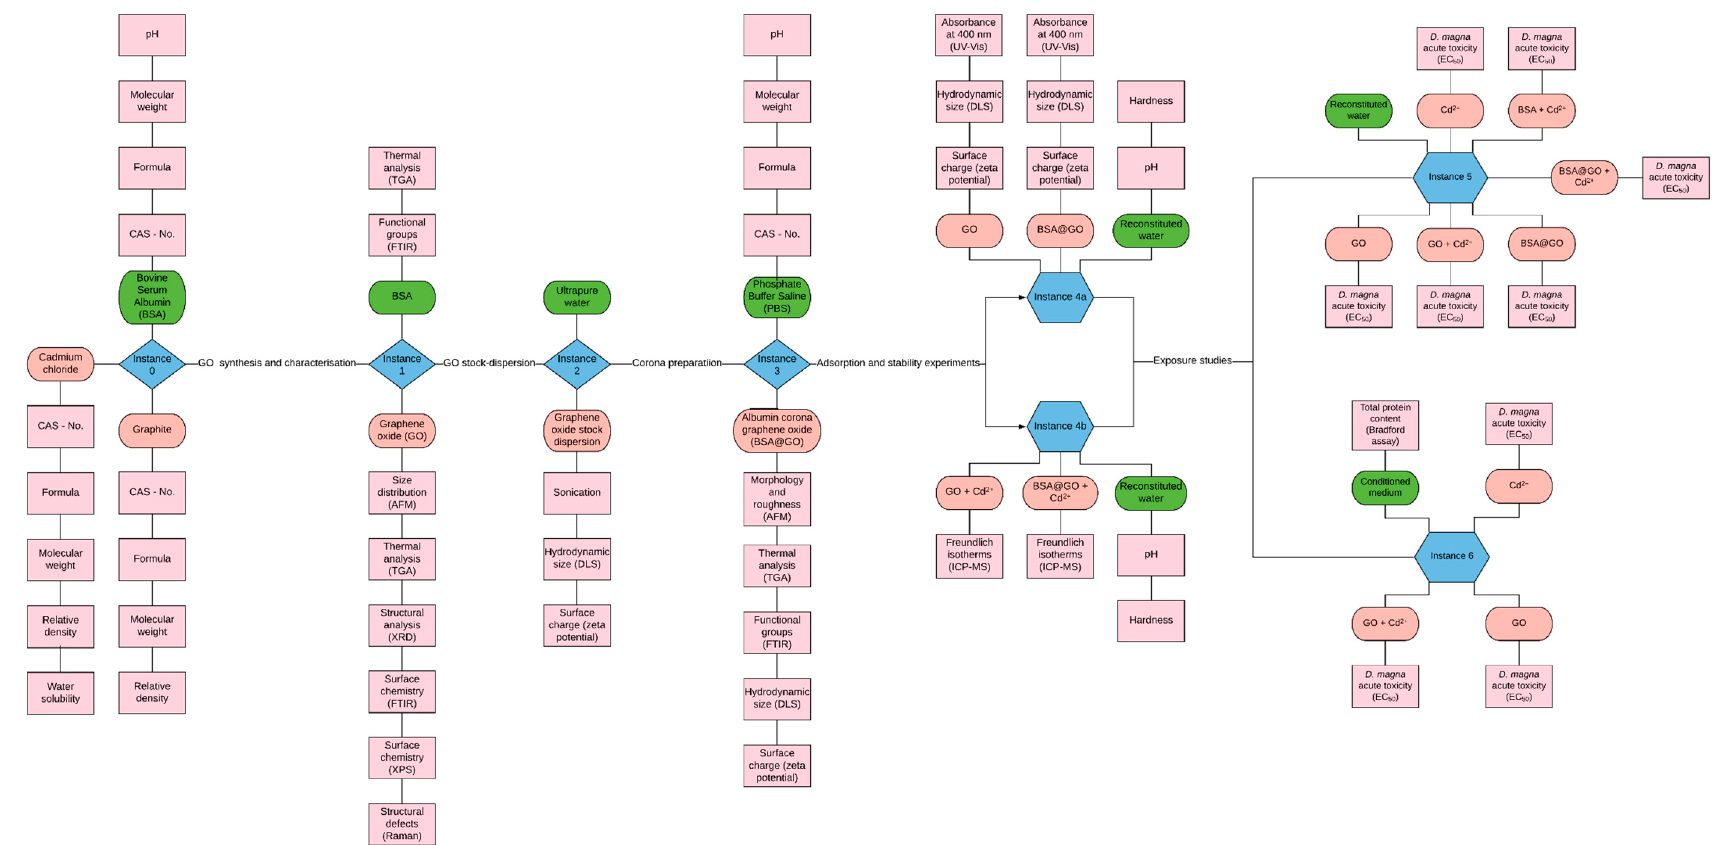
Figure 1. Experimental workflow used for integration of the datasets into the NanoCommons Knowledge Base. Note that the characteristics of each of the components (nanomaterials, media, proteins and co-pollutants) are included as part of the overall dataset and each instance represents a change to the overall system (e.g., a dispersion step, a corona formation step etc.).